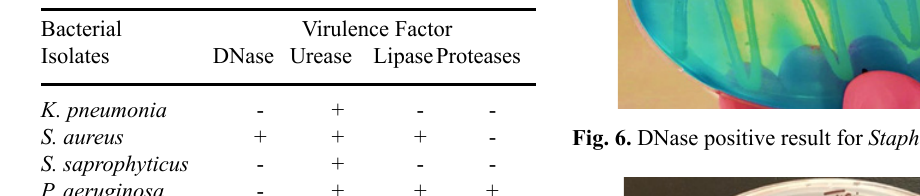
PS bacterial isolated from UTI